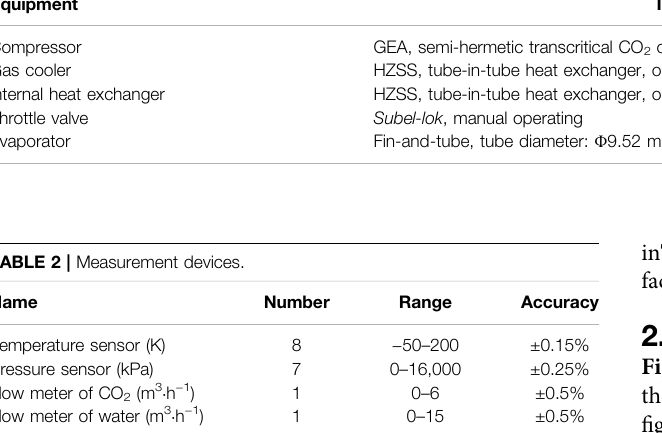
TABLE 1 | Speci fi c parameters of the apparatus. Equipment